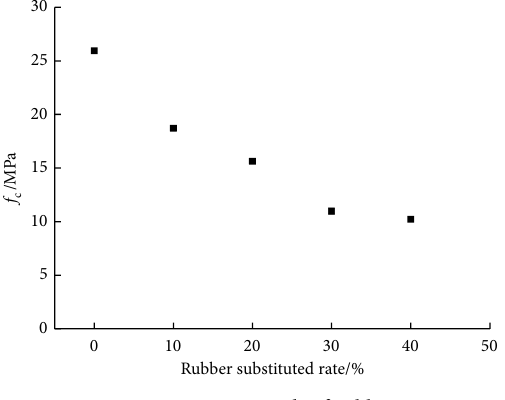
Figure 5. Compressive strength of rubber concrete with different substitution rates